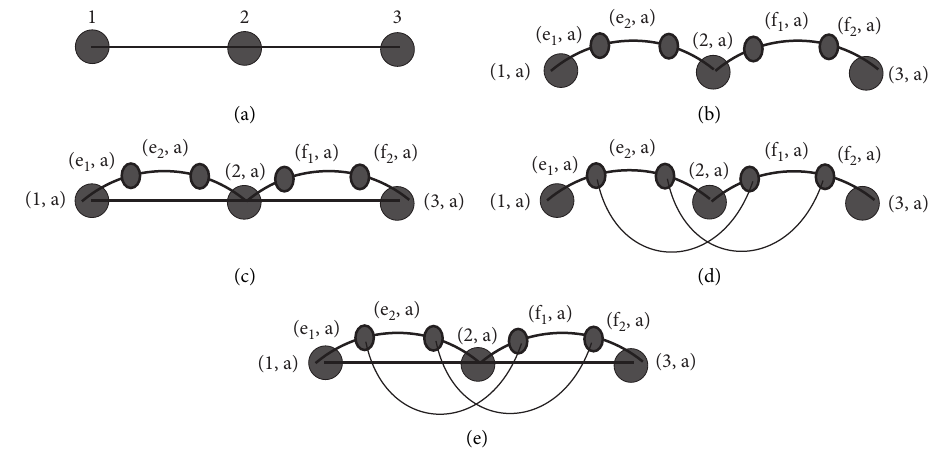
Figure 1: (a) Γ , (b). S